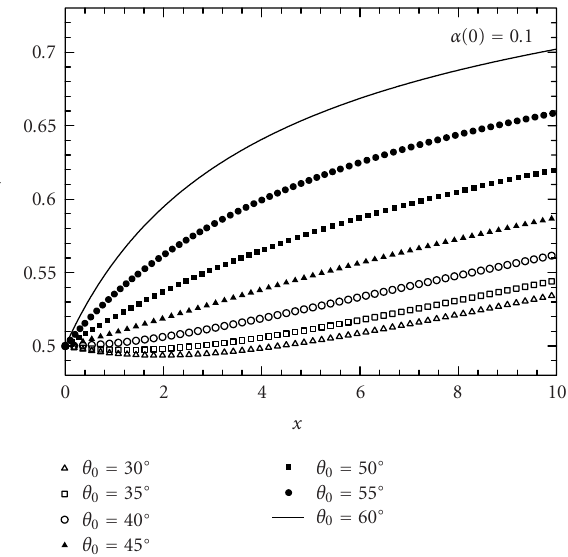
Figure 6: The inlet distortion propagates along axial direction at smaller inlet incident angles, θ 0 ≤ 25 ◦ . Figure 7: The inlet distortion propagates along axial direction at higher inlet incident angles, θ 0 ≥ 25 ◦ .